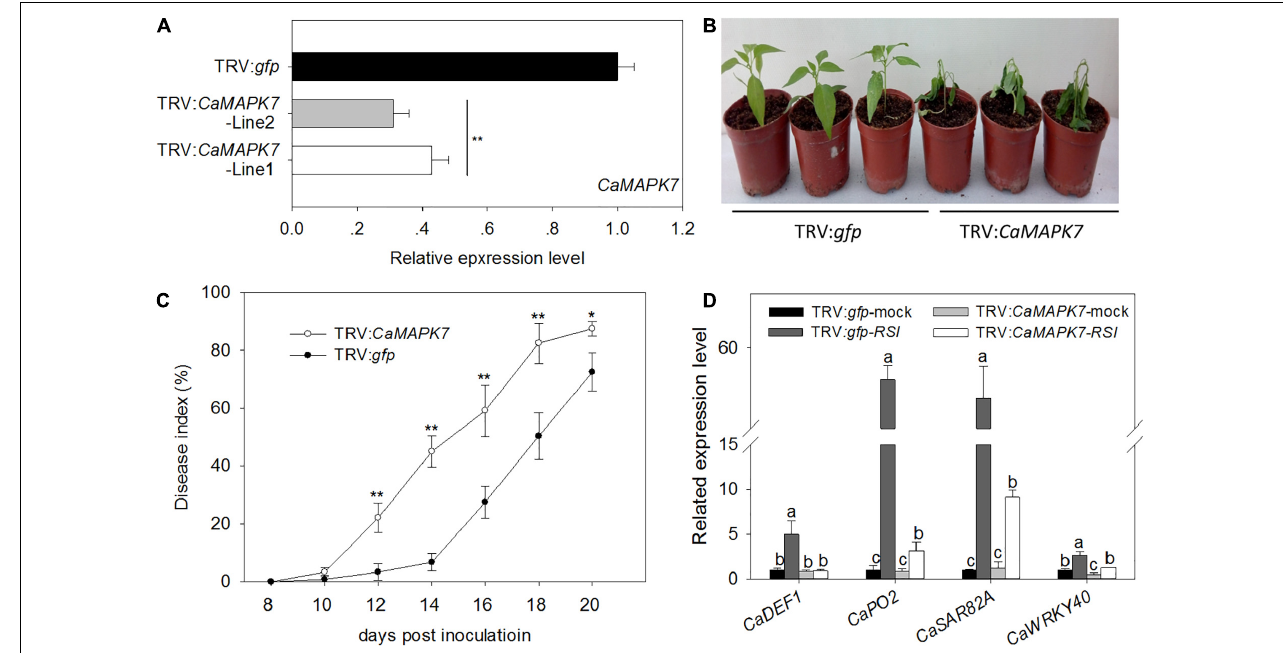
FIGURE 4 | Increased susceptibility of CaMAPK7 -silenced pepper plants to Ralstonia solanacearum infection. (A) Relative CaMAPK7 transcript levels in empty vector control (TRV: gfp ) and silenced (TRV: CaMAPK7 ) plants investigated by qRT-PCR. (B) The phenotype of CaMAPK7 -silenced and unsilenced pepper plants 14 days post- R. solanacearum inoculation. (C) R. solanacearum -inoculated leaves scored every 2 days using a disease index ranging from 0 to 4: 0 (no wilting), 1 (1–25% wilted), 2 (26–50% wilted), 3 (51–75% wilted), and 4 (76–100% wilted or dead). The averages presented are based on three biological replicates each comprising 10 plants. (A–C) Error bars indicate the standard error. Asterisks indicate a significant difference as determined by the two-tailed t -test (* p < 0.05; ** p < 0.01). (D) Real-time RT-PCR analysis of defense marker gene expression in CaMAPK7 -silenced and unsilenced pepper plants 48 h post-inoculation with R. solanacearum . The relative expression of defense marker genes in unsilenced pepper leaves without pathogen inoculation was set to “1.” Data represent the means ± SD from three biological replicates. Different letters indicate significant differences in gene expression, as determined by Fisher’s protected LSD test ( p < 0.05). dai, days after inoculation; SD, standard